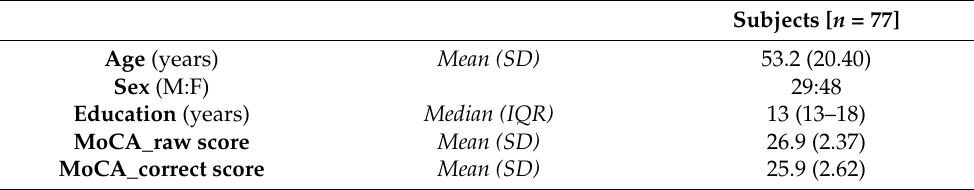
Table 3. Demographic and MoCA scores of the whole